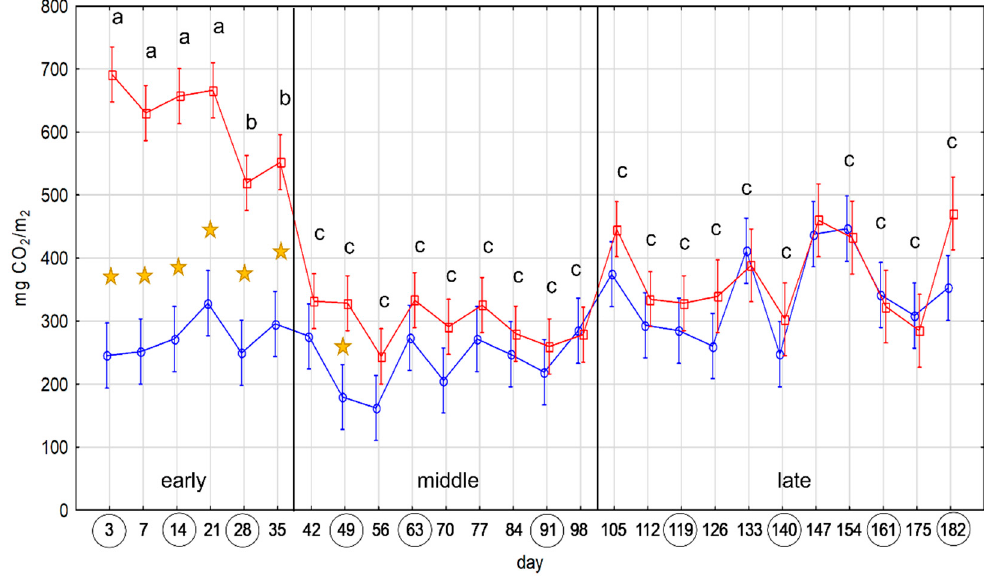
Figure 1. Soil respiration (SR) data. On the Y-axes are SR values in mg CO 2 per m 2 , and on the X axis are days of measurement. The blue line corresponds to the SR values of containers with soil without added straw (control). The red line corresponds to SR values of containers with soil with added straw in sachets (experiment). Vertical red and blue bars denote 0.95 confidence intervals. Stars mark significant ( p -value ≤ 0.05) differences between the experiment and control values. Groups of experimental SR values without significant ( p -value ≤ 0.05) differences are marked with the same letter (‘a’, ‘b’, and ‘c’). Vertical black bars mark different phases of decomposition: early, middle, and late. Circles around days on the X -axis denote the samples chosen for amplicon